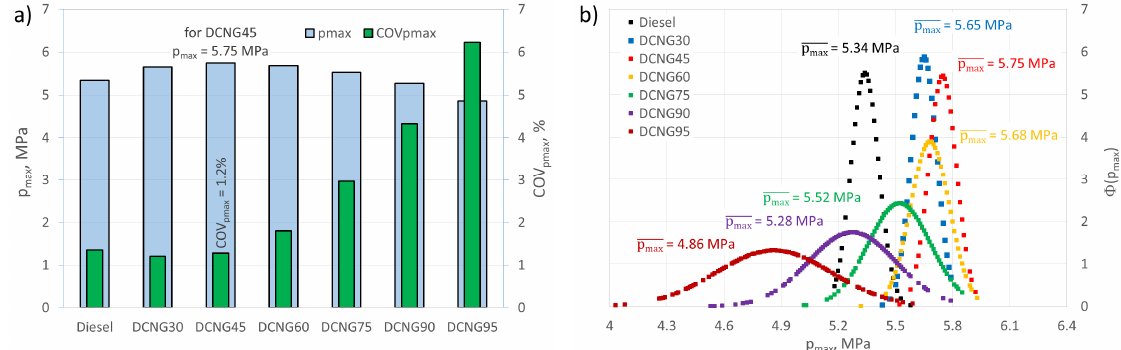
Figure 5. Mean maximum pressure, COV pmax ( a ), and pressure probability density, Φ (p max ) ( b )